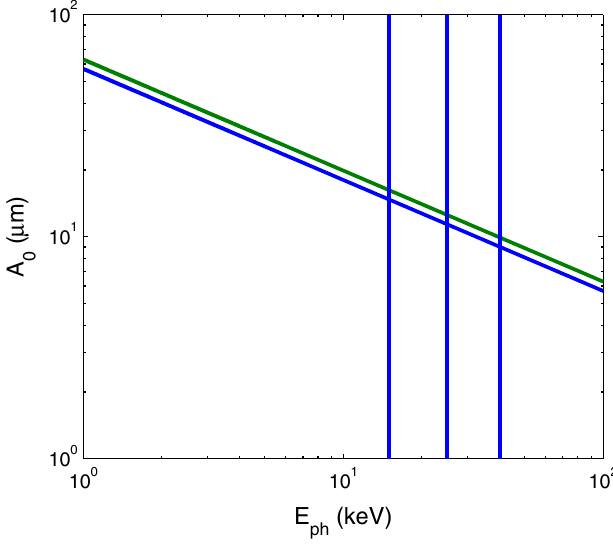
FIG. 2. (Color) Optimum pinhole aperture vs photon energy. The vertical lines show photon energies at 15, 25, and 40 keV, which are close to the minimum energy filtered by the Al window, close to the peak and some higher photon energy,